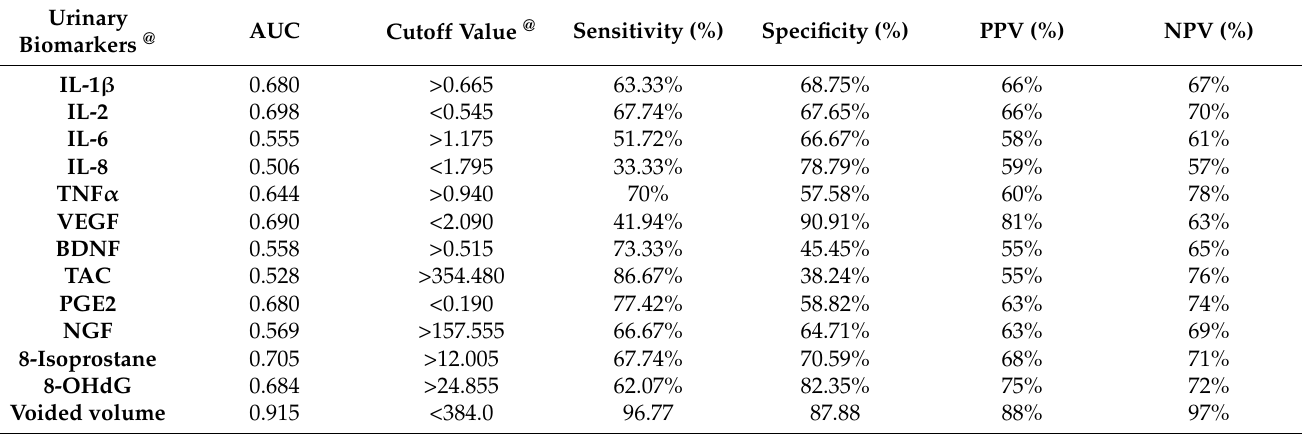
Table 3. Diagnostic values of urinary biomarkers and voided volume between the USI and DO and control